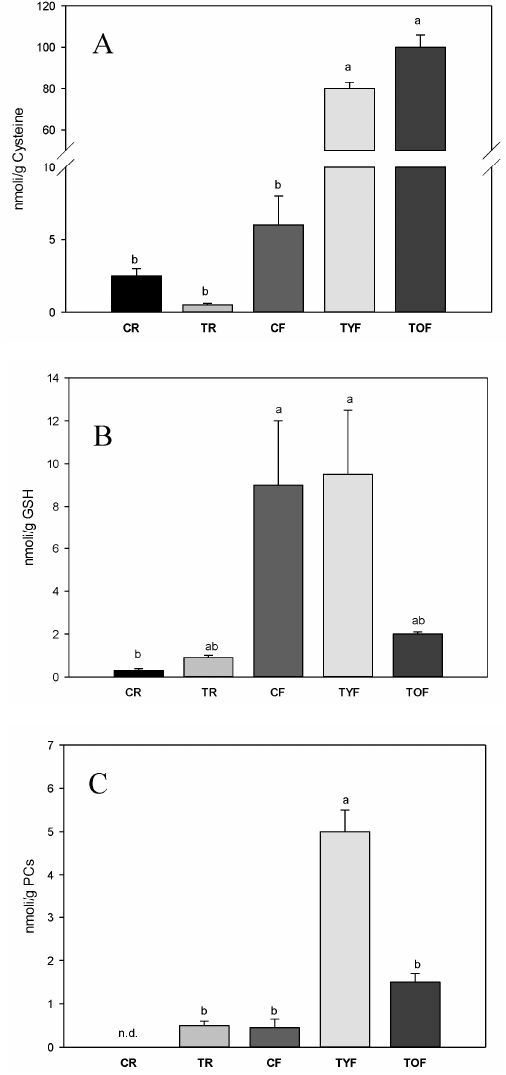
Figure 3. Thiol ( A , cysteine; B , glutathione) and total phytochelatin ( C , PCs) content in Pteris vittata L. plants treated (T) or not (C) for 9 weeks with 28 mg L − 1 Na 2 HAsO 4 ·7H 2 O under hydroponic conditions in greenhouse (CR, control root; CF, control fronds; TR, treated root; TYF, treated young fronds; TOF, treated old fronds). Vertical bars represent means ( n = 5) ± S.D. Two-way ANOVA was applied; different letters indicate significant difference according to Tukey’s test ( p ≤ 0.05; nd = not detected).